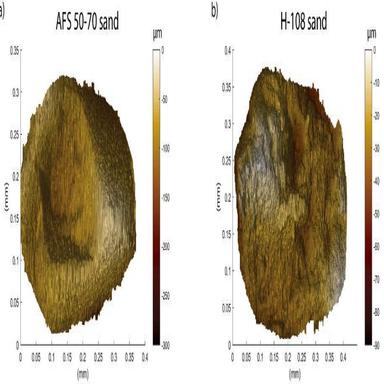
Topographic details from selected NOP studies of sand grains. (a) AFS 50–70 and (b) H-108.